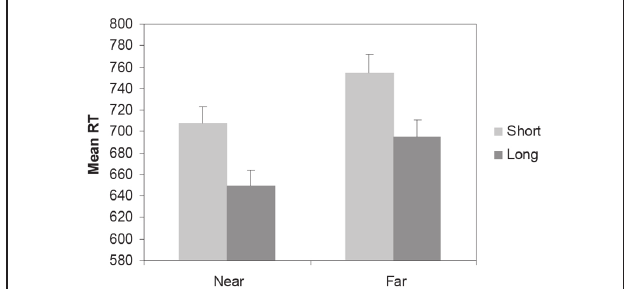
FIGURE 2 | Mean RTs ( + SEM) for the priming/recognitiontask for near/far priming relations, according to the amount of experience with the city of Utrecht (short/long).